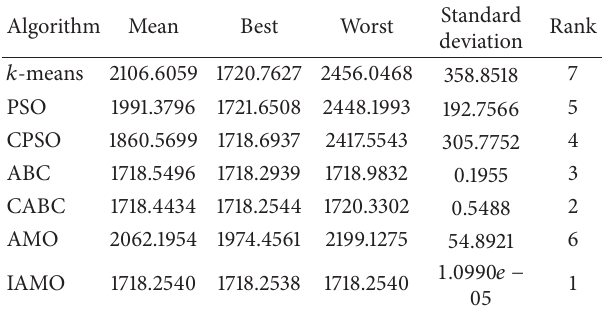
Table 1: Results obtained by the algorithms for 20 different runs on